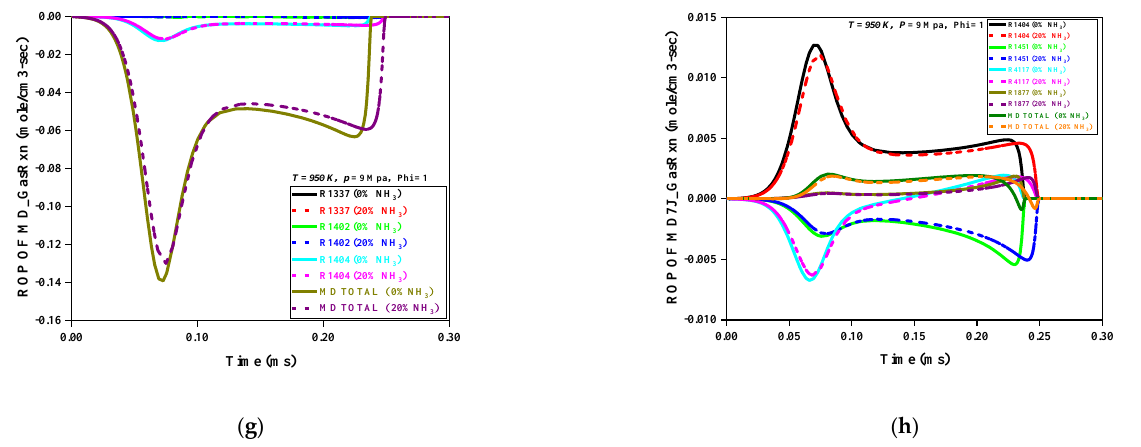
Figure 5. ROP analysis of MD and MD7J with different moles of NH 3 at temperatures of 800 K and 950 K and pressures of 6 MPa and 9 MPa: ( a ) ROP of MD at T = 800 K and p = 6 MPa; ( b ) ROP of MD7J at T = 800 K and p = 6 MPa; ( c ) ROP of MD at T = 950 K and p = 6 MPa; ( d ) ROP of MD7J at T = 950 K and p = 6 MPa; ( e ) ROP of MD at T = 800 K and p = 9 MPa; ( f ) ROP of MD7J at T = 800 K and p = 9 MPa; ( g ) ROP of MD at T = 950 K and p = 9 MPa; ( h ) ROP of MD7J at T = 950 K and p = 9 MPa.